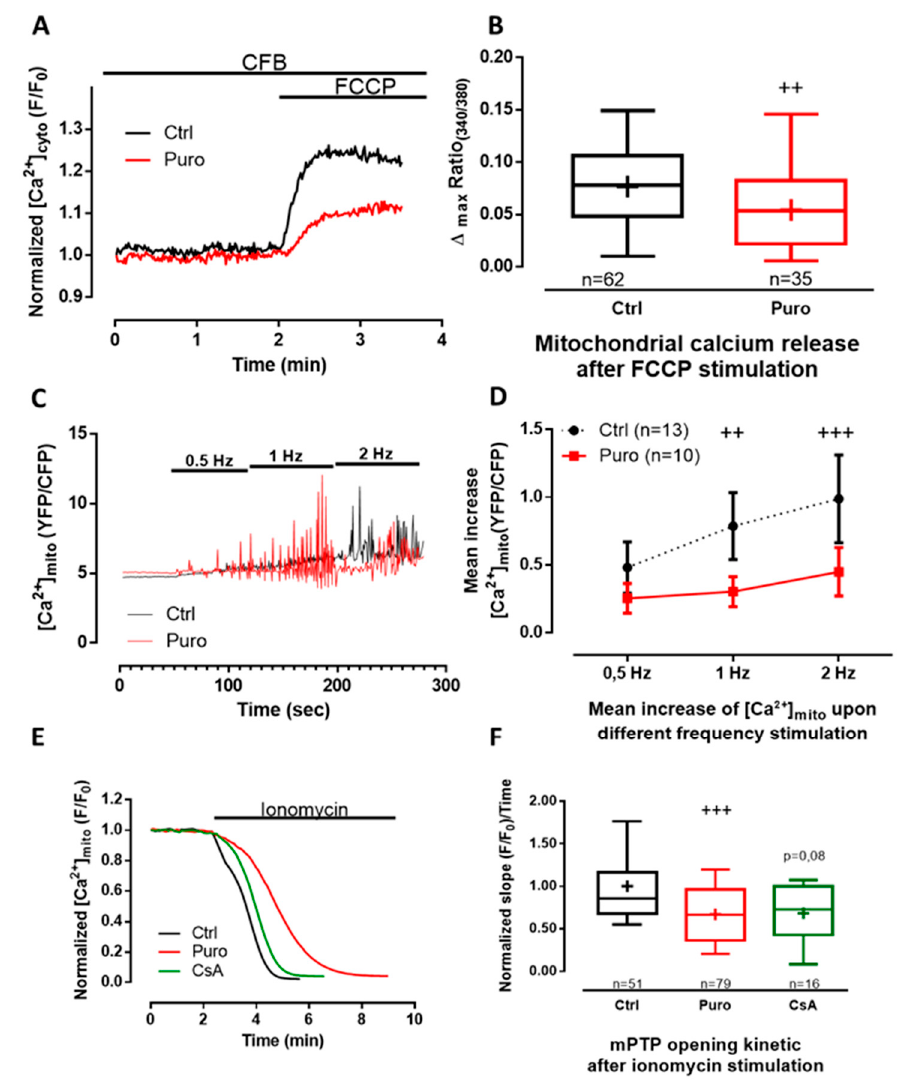
Figure 3. Puromycin pretreatment modified mitochondrial Ca 2+ content in beating CM and delays mitochondrial permeability transition pore (mPTP) opening. ( A ) Representative time traces of mitochondrial Ca 2+ concentration (expressed as the 340/380 fluorescent ratio of fura2-AM cytosolic probe)) from Ctrl and CM pretreated with 200 μ M of puromycin for 30 min. ( B ) Boxplots represent mitochondrial calcium content assessed by 25 μ M of FCCP (Carbonyl cyanide 4-(trifluoromethoxy)phenylhydrazone ) stimulation (expressed by the delta max of the 340/380 fluorescent ratio of fura2-AM cytosolic probe) in Ctrl condition and after 30 min of 200 μ M puromycin pretreatment. ( C , D ) Mitochondrial Ca 2+ rises recorded in 4mtD3cpv-positive CM electrically stimulated successively at 0.5, 1, and 2 Hz. ( C ) Representative time traces of mitochondrial Ca 2+ concentration in Ctrl and after 30 min of puromycin pretreatment, expressed as YFP/CFP fluorescent